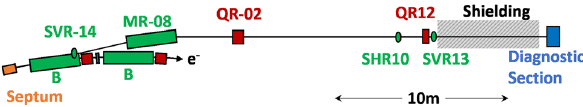
Fig. 19 Overview of the former DORIS transfer line from the extrac- tion region up to the diagnostic section which is located behind a shield- ing wall in the old transfer tunnel. The line consists of a bending mag- net (MR-08) and a pair of horizontally (QR-02) and vertically (QR12) focusing quadrupoles. Fine alignment of the beam position is possible via steerer magnets in horizontal (SHR10) and vertical (SVR-14 and SVR13) direction. The direction of the circulating beam (e − ) is indi- cated by the arrow. The distance between the extraction point and the detector section is about 35 m